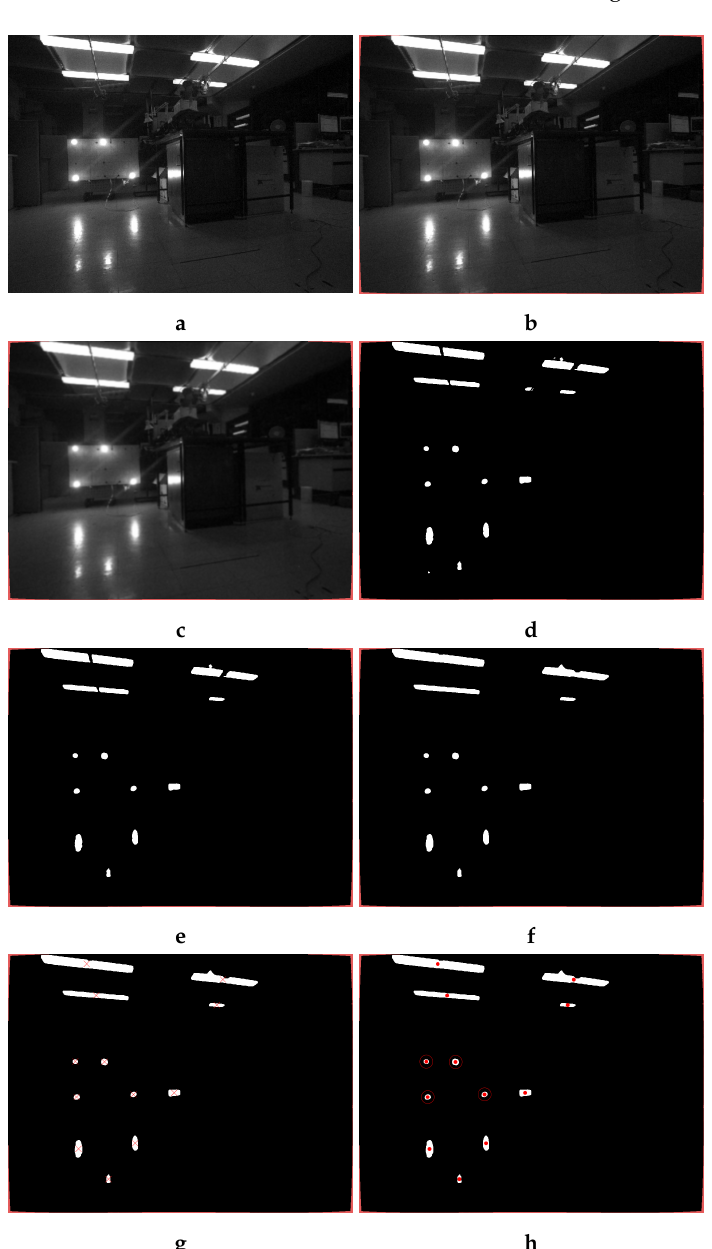
Figure 5. Image processing stages. Image acquisition ( a ); image undistorted ( b ); image blurred ( c ); image binarization ( d ); objects with less than P pixels removed ( e ); image morphologically closed ( f ); finding centres of remaining object and calculating object roundness ( g ); four roundest objects chosen ( h